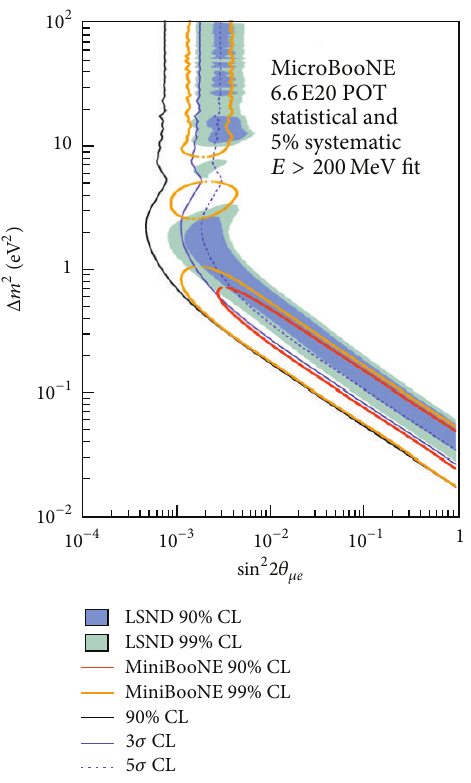
Figure 18: The MicroBooNE sensitivity to ] 𝜇 → ] 𝑒 oscillations. Also the allowed regions from LSND and from the MiniBooNE combined fit are shown.